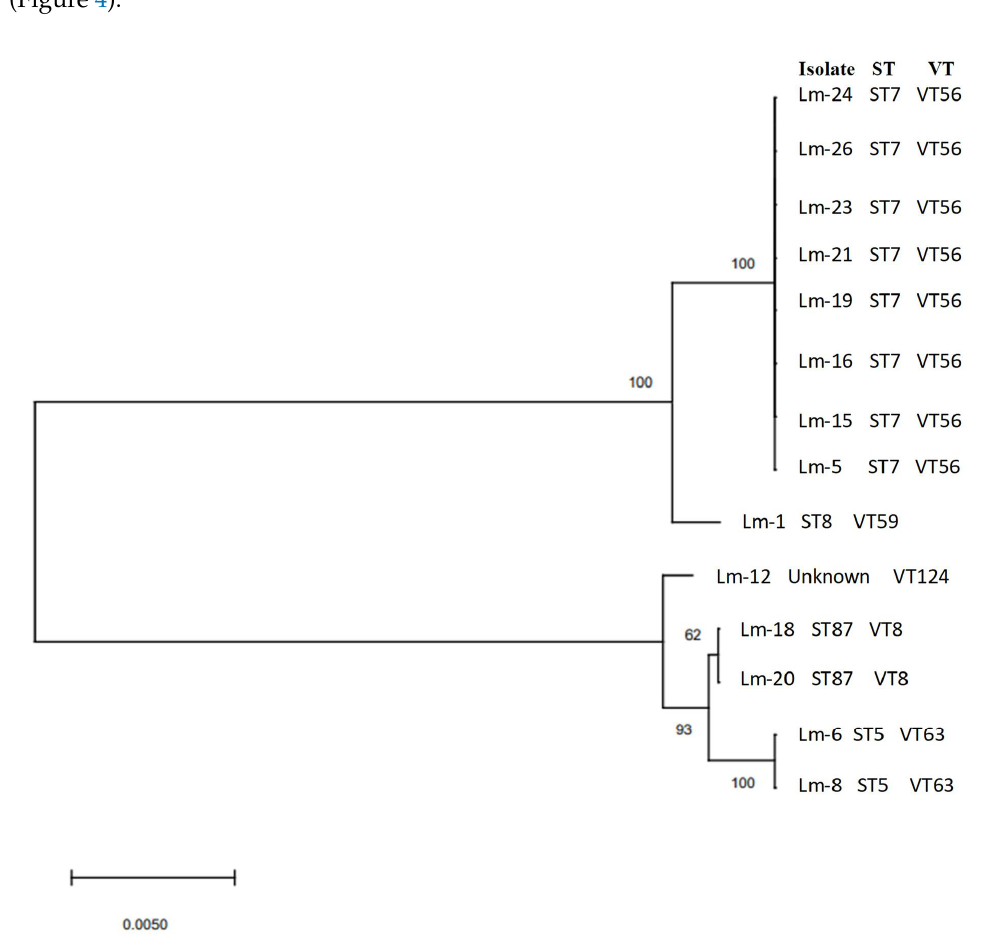
Figure 4. Unrooted neighbour-joining tree of the fourteen L. monocytogenes isolates obtained from the final product (FP), FCS and n-FCS of the frozen vegetable plant based on a multi-virulence-locus sequence typing (MVLST) analysis. Information on the sequence type (ST) and virulence type (VT) of each L. monocytogenes isolate is shown.